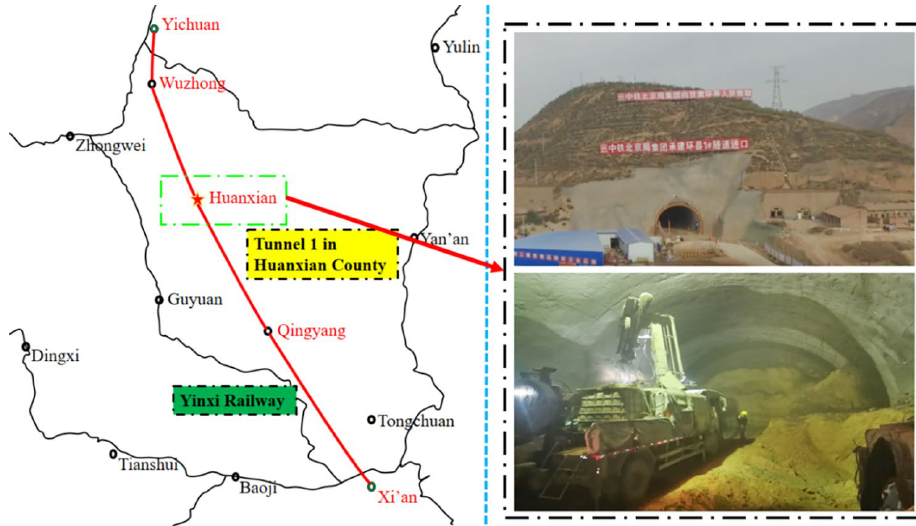
Figure 4. Diagram of the location of Tunnel 1 in Huanxian County